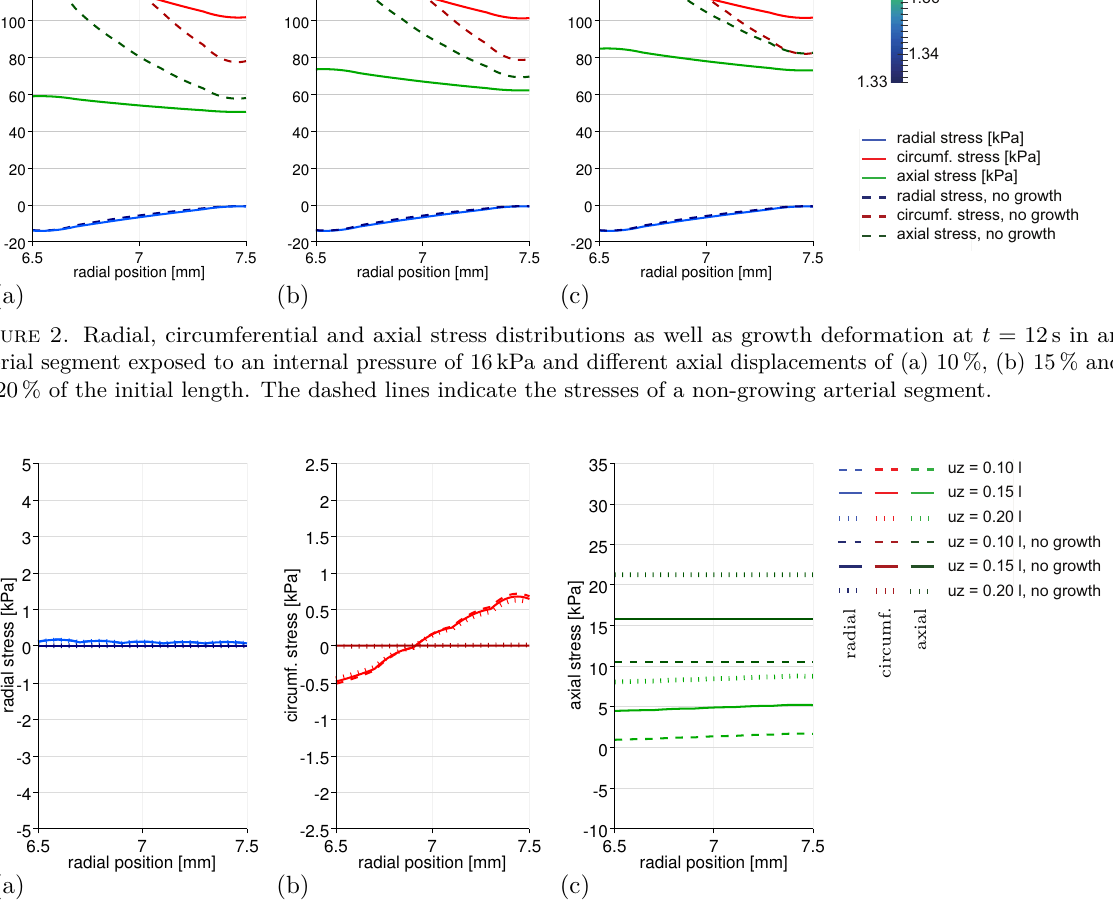
Figure 3. Residual stresses in (a) radial and (b) circumferential direction, as well as (c) stresses in axial direction at t = 12 s after removing the internal pressure while keeping up the axial displacement. The stress distributions provoke the axial contraction and opening of a resected, radially sliced arterial segment as it is observed in experiments.